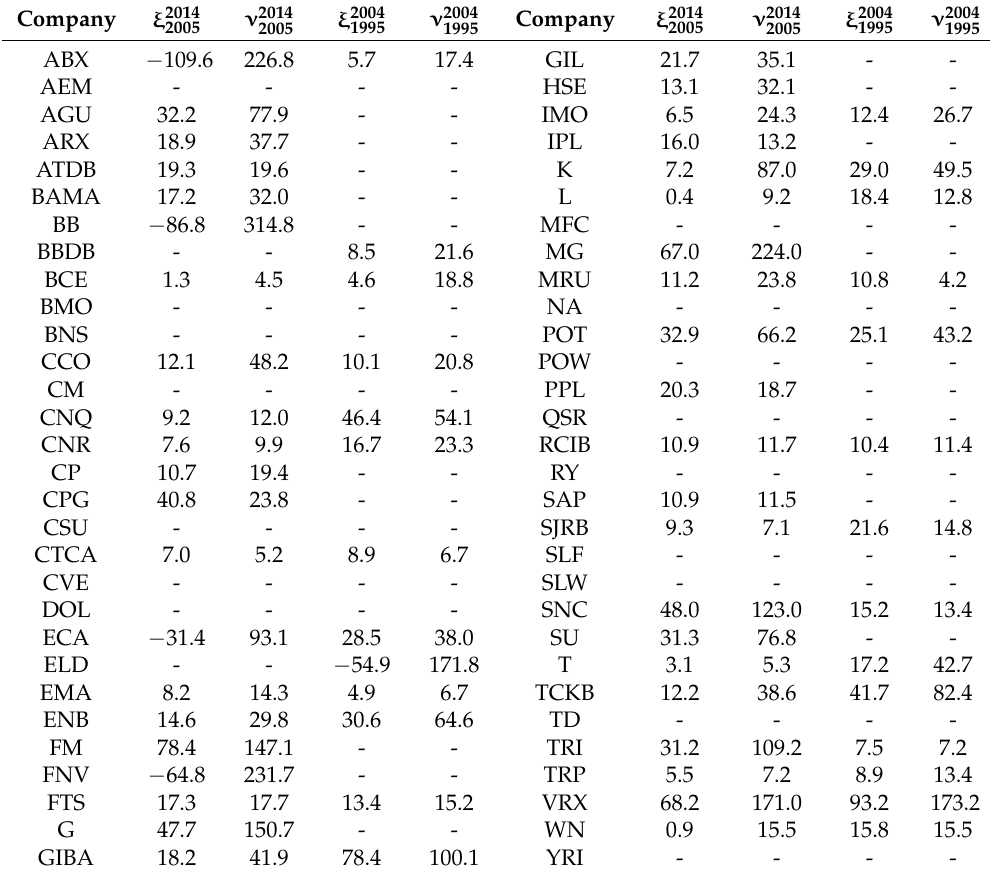
Table A5. Estimated parameters ξ ( % ) and ν ( % ) , for each company of SPTSX60 index. Company